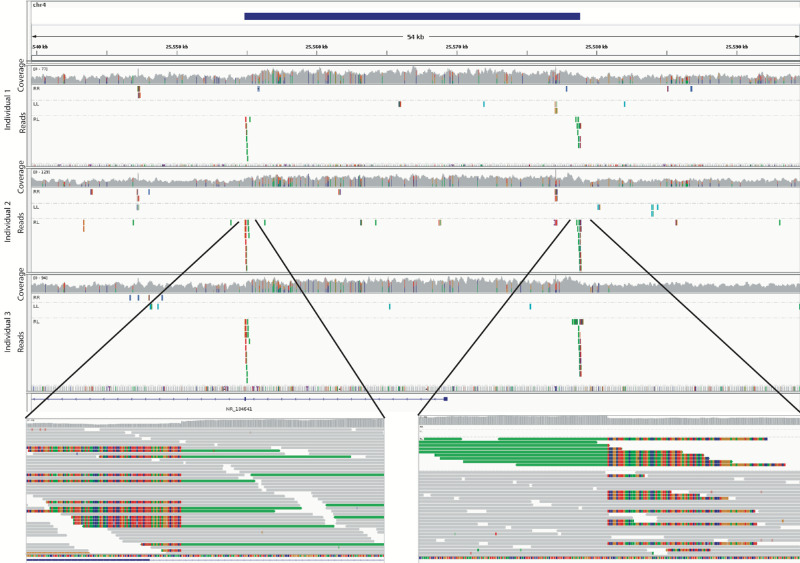
Breakpoints of chromosome 4 duplication. Whole genome sequences from three unrelated individuals with esotropia who harbor the chromosome 4 duplication show increased sequence coverage across the duplication and split reads at the breakpoints. Top: Schematic of chromosome 4 region of duplication. Middle: Images from integrated genome viewer for each of three individuals. Coverage is indicated for each base pair by the height of the gray bar, split reads are shown in red and green below. Green reads indicate that the paired read maps further away than expected. Bottom: individual reads are shown across the breakpoints. The split reads (colored by base-pair that does not map to the reference sequence) were mapped back to indicate this is a tandem duplication. The left breakpoint (hg38: 4:25,554,985) is just upstream of exon 2 of LOC101929. The right breakpoint (hg38: 4:25,578,843) is in an intergenic region.